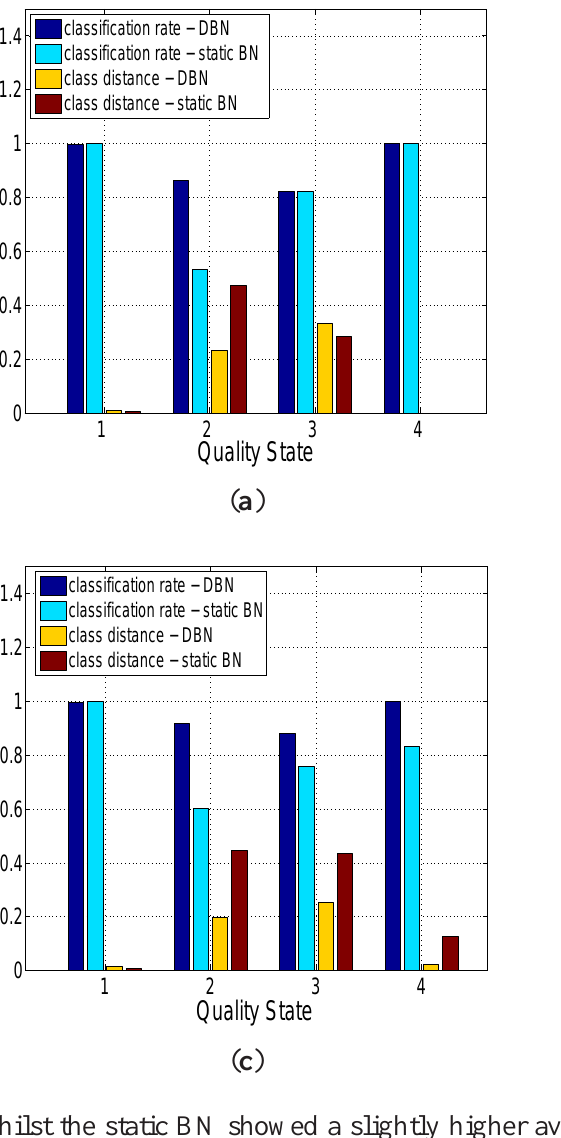
Figure 6. The automated quality assessments from two BN (static BN and DBN) compared to expert quality assessments across the four sensors in Sullivans Cove, Hobart. The quality state labels 1 to 4 define the quality states in Table 1. There were two metrics used to compare the assessment performance of the Bayesian networks. The first metric was the distance between the quality state with maximum posterior probability and the quality state selected by an expert. The second metric was the distance between the expert’s quality state and the continuous quality label of the network defined in Equation (11). ( a ) Temperature Sensor at 1 m; ( b ) Conductivity Sensor at 1 m; ( c ) Temperature Sensor at 10 m; ( d ) Conductivity Sensor at 10